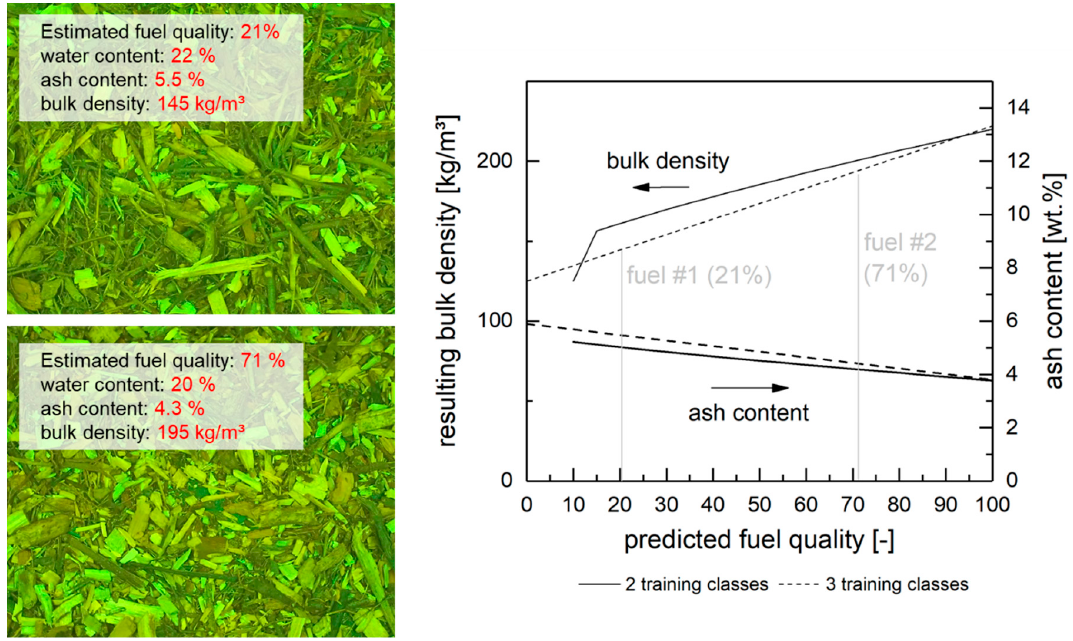
Figure 10. ( left ): Estimating fuel properties from calculated mixture ratios; ( right ): Interpolation of bulk density and ash content from calculated mixture ratios for two and three training classes.